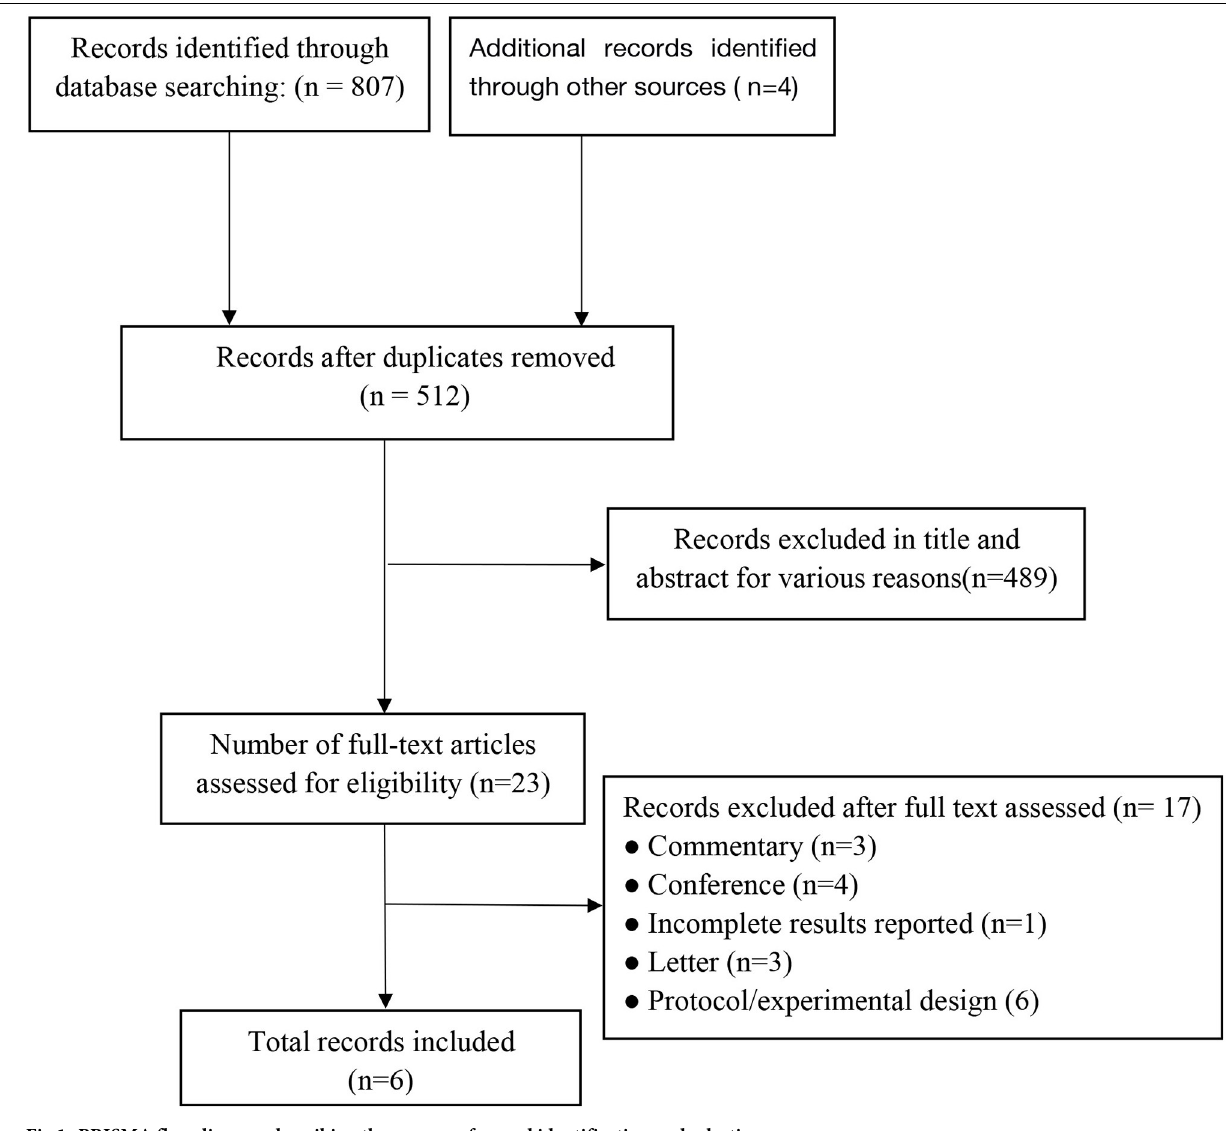
Fig 1. PRISMA flow diagram describing the process of record identification and